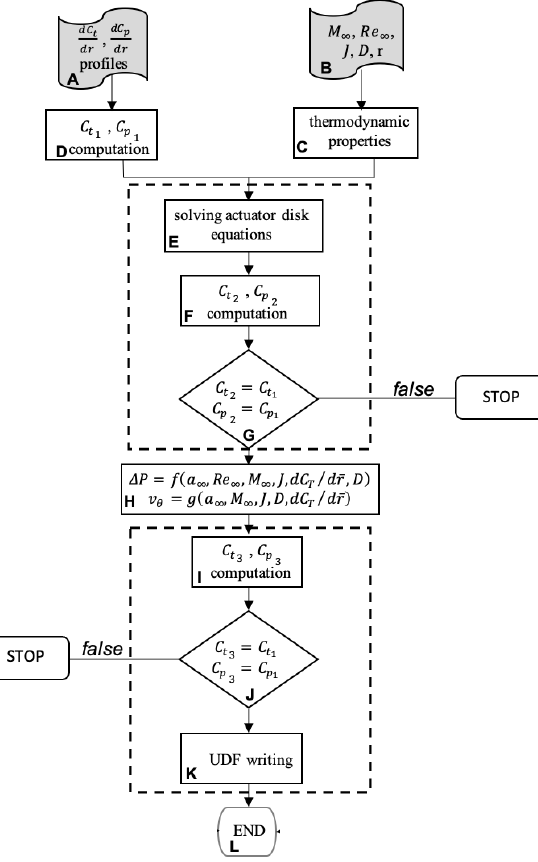
Figure 3. Flowchart diagram to write the UDF.